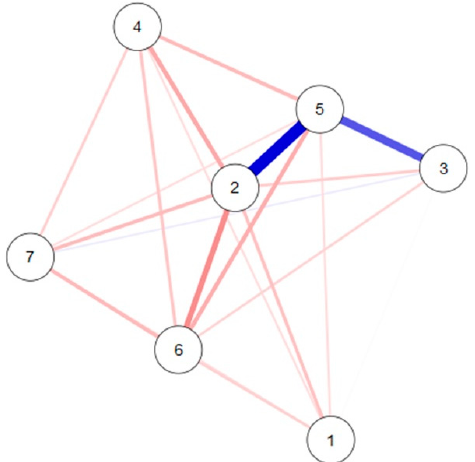
Figure 8. JASP (Jeffreys’s Amazing Statistics Program) plot of the algal communities similarities in seven studied sites of the bogs of the Ershov oil field in the Vakh River basin of the KMAO-Yugra. Number of sites as in Table 1.